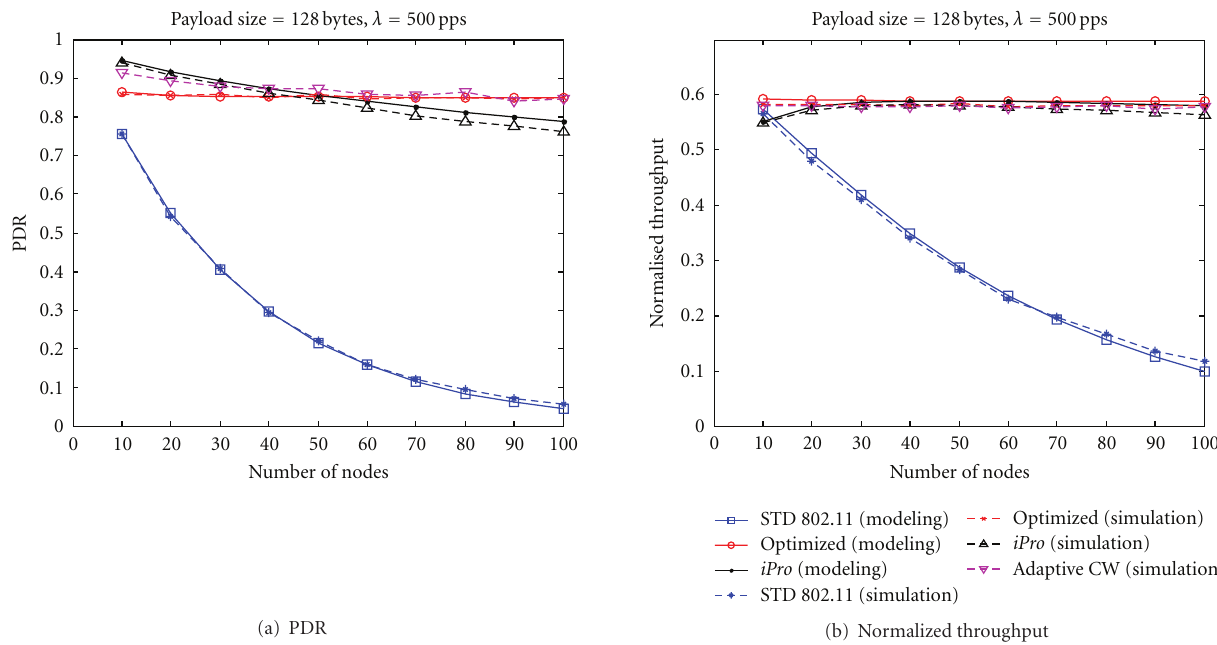
Figure 5: PDR and normalized throughput for payload equal 128